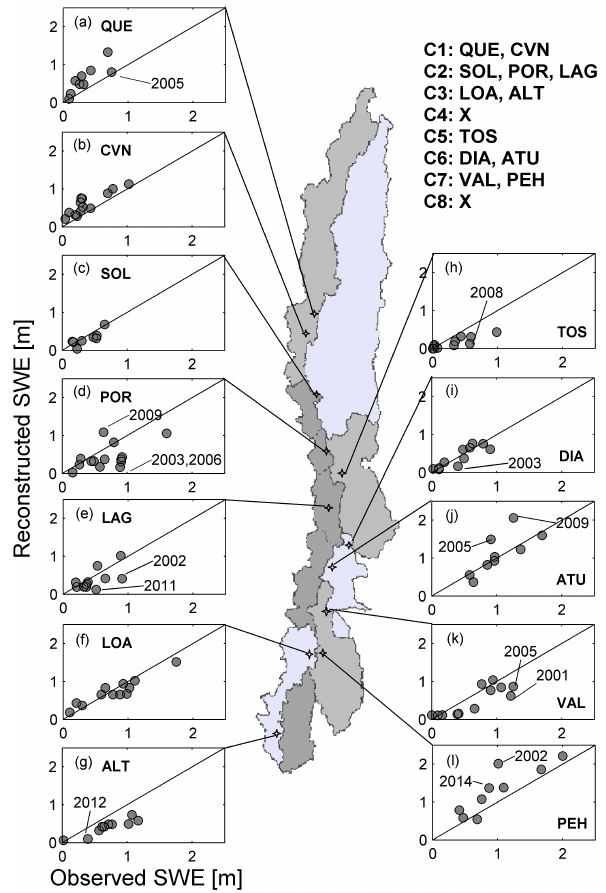
Figure 5. Comparison between peak reconstructed and observed SWE at snow-pillow sites. Solid line represents the 1:1 line.